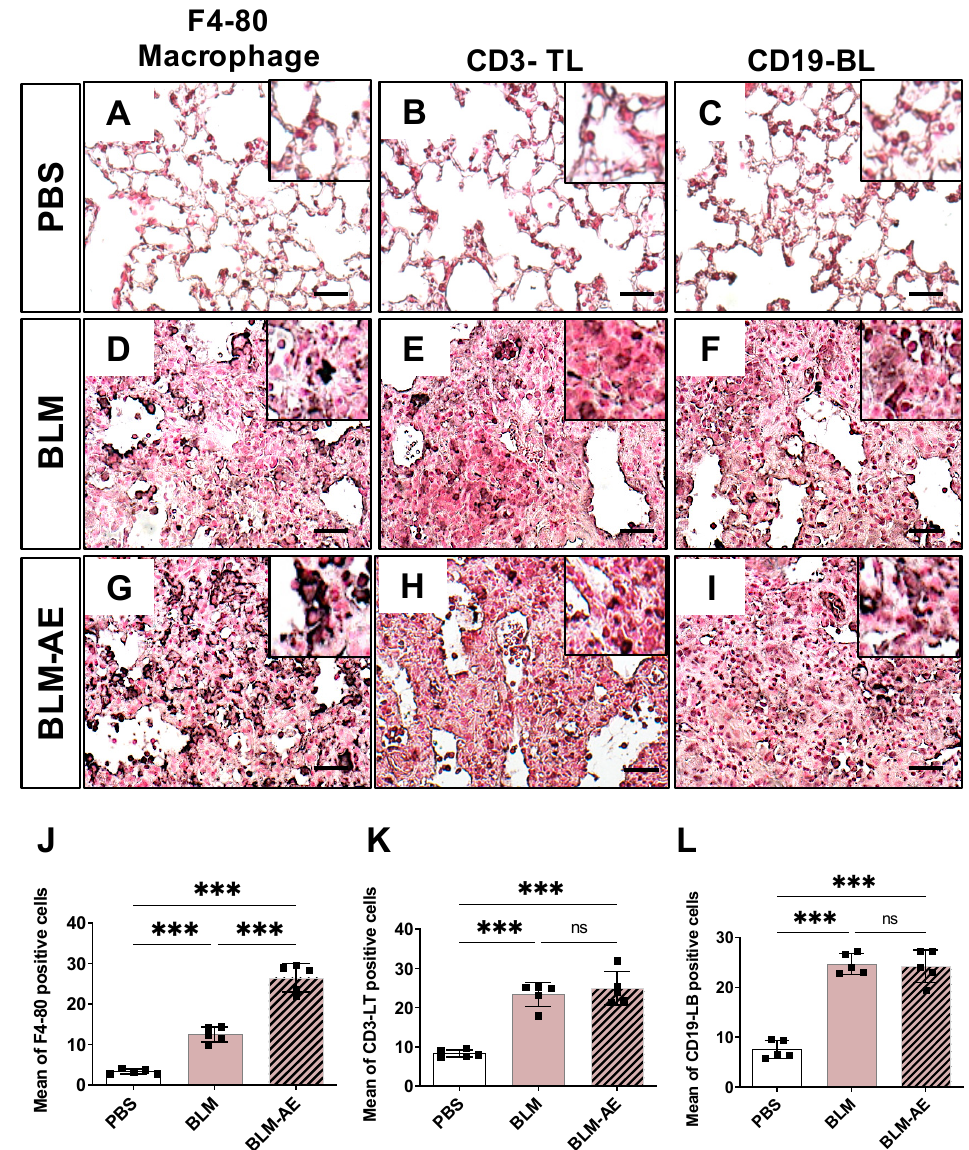
Figure 5. Identification of macrophage and lymphocyte cell populations. ( A , D , G ) Immunostained representative lung sections for F4-80 macrophages, ( B , E , H ) CD3 T lymphocytes and ( C , F , I ) CD19 B lymphocytes identification in the PBS ( A – C ), BLM ( D – F ), BLM-AE ( G – I ) groups. Scale bar corresponding to 100 µ m. A representative image of the PBS, BLM and BLM-AE groups is shown. After BLM instillation, infiltration of F4-80 macrophages is observed in the BLM group ( D ) and an upsurge is shown after exacerbation (BLM-AE, ( G )). T lymphocyte infiltration was observed in the BLM group (( E , F ), respectively) and after exacerbation (( H , I ), respectively). ( J ) Quantification of macrophages, ( K ) CD3-LT and ( L ) CD19-LB in the control PBS group (white bar), BLM group (pink bar) and BLM-AE group (pink hatched black bar). Six mice from the PBS group, six mice from the BLM group and seven mice from the BLM-AE were photographed. For each field in each mouse and in each condition, the average number of positive cells for F4-80, CD3 and CD19 immunolabelling was reported to the total number of cells present. All values are represented as median ± interquartile range; one-way ANOVA analysis followed by Newman–Keuls was performed. ns: not significant *** p ≤